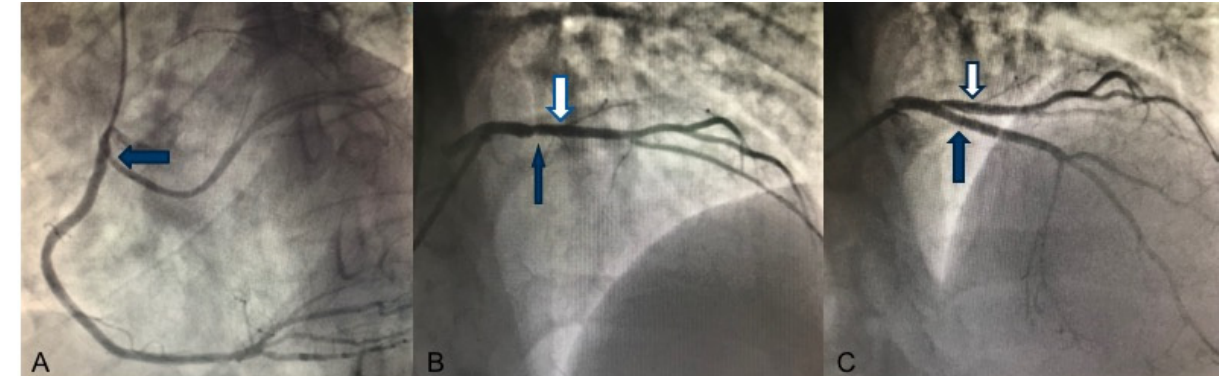
Figure 1. Coronary angiography. ( A ) Left oblique angiographic view: anomalous origin of the LCx (blue arrow) from the RCA. ( B ) Anteroposterior cranial angiographic view: large-caliber diagonal branch (white arrow) and critical stenosis of the proximal LAD artery that appears not viewable (blue arrow) ( C ) Anteroposterior cranial angiographic view: result after primary PCI and a DES implantation in proximal LAD (blue arrow) with effective restoration of the vessel’s patency and downstream flow. Large-caliber diagonal branch (white arrow).